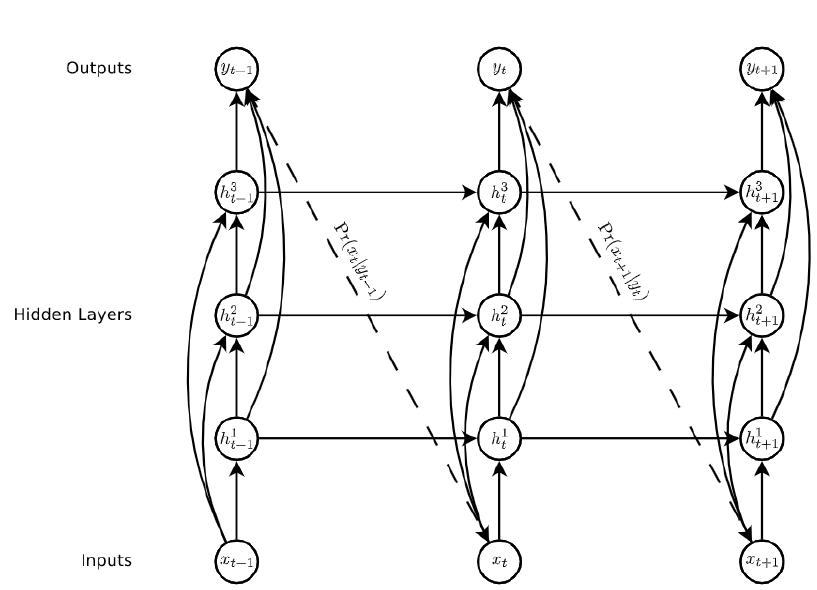
Figure 4. Deep recurrent neural network prediction